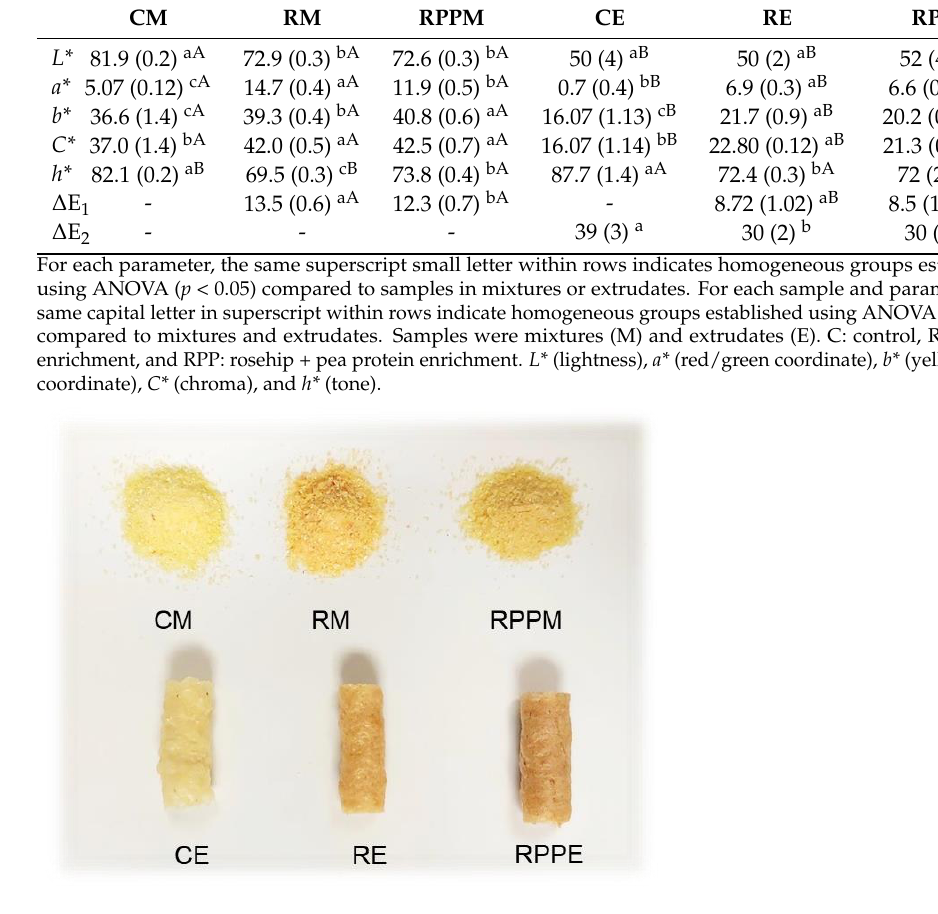
Figure 1. Appearance of studied mixtures (M) and extrudates (E). C: control, R: rosehip enrichment, and RPP: rosehip + pea protein enrichment.